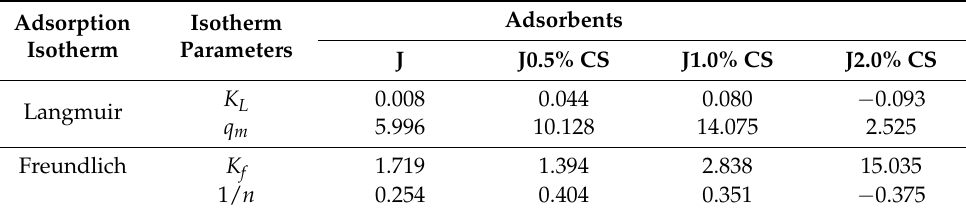
Figure 9. Modeling the isotherm data presented in Figure 8 using: ( a ) Langmuir and ( b ) Freundlich isotherm models and the linear fit of experimental data for RO 16 adsorption. Table 2. Isotherm parameters for RO 16 adsorption onto studied